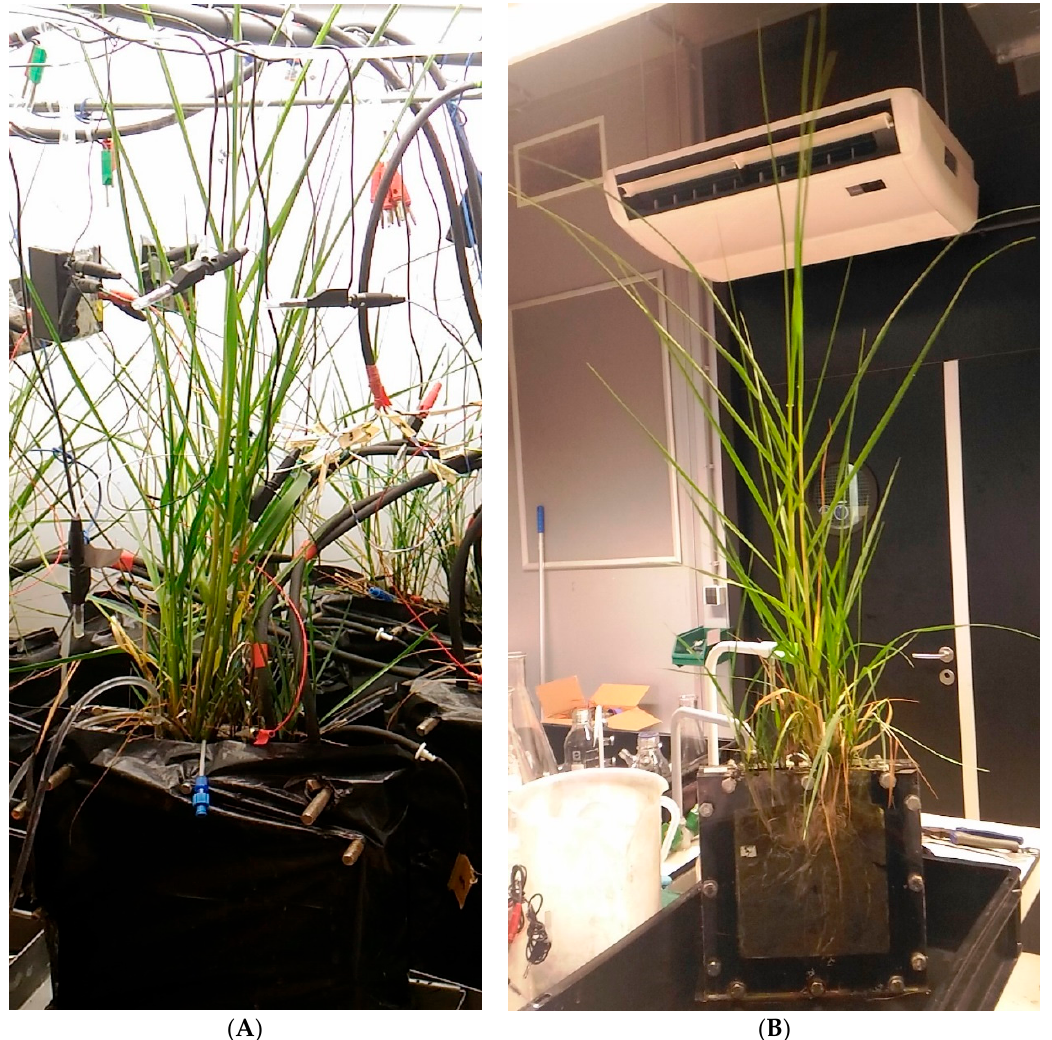
Figure 1. Full-grown Spartina anglica in Plant-MFC 3 (MS100); ( A ) inside the climate chamber and ( B ) at the end of the experiment.